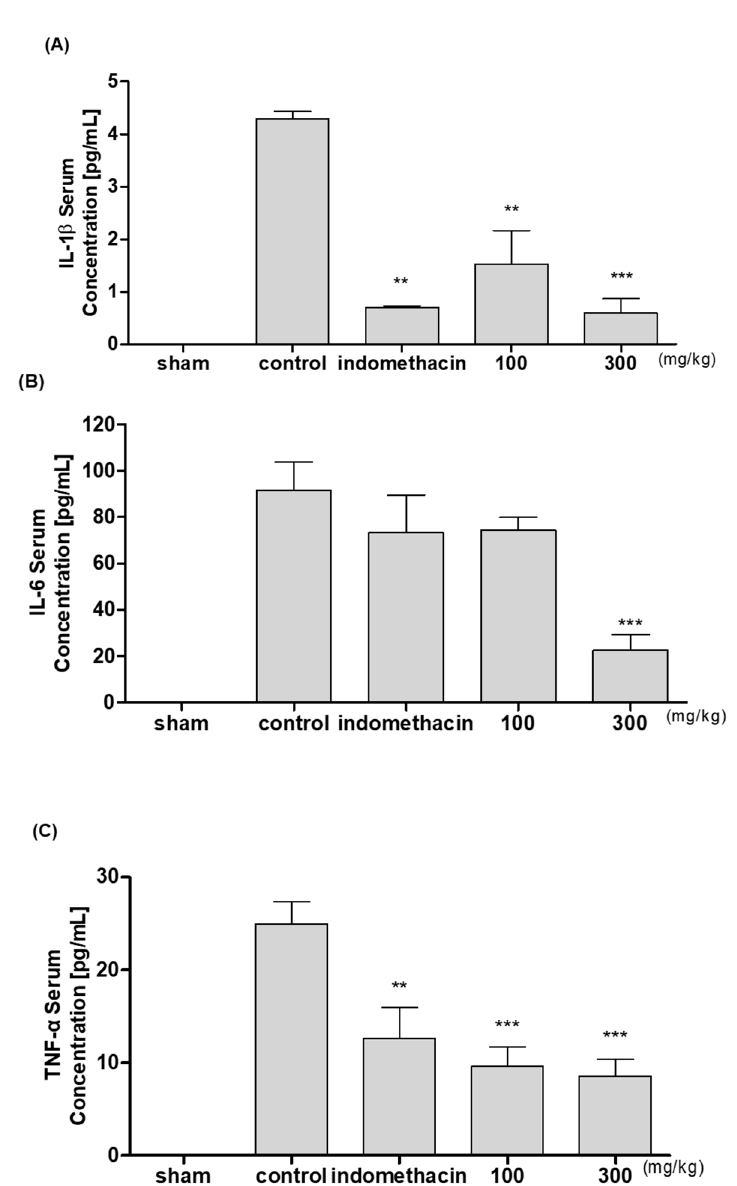
Figure 4. The inhibitory effects of A. paniculata extract (APE) extract on serum inflammatory cytokine levels in monosodium iodoacetate (MIA) rats. Rats were treated with 100 and 300 mg/kg APE for 24 days, ** p < 0.01 vs. control, *** p < 0.001 vs. control by one-way ANOVA, Dunnett’s test.